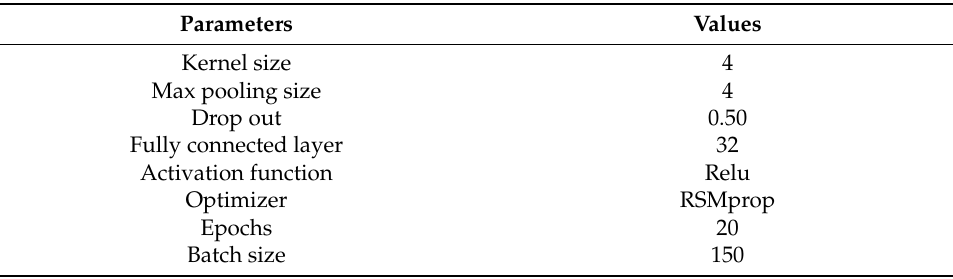
Figure 8. The structure of the CNN-LSTM model. Table 2. Parameters of the CNN-LSTM